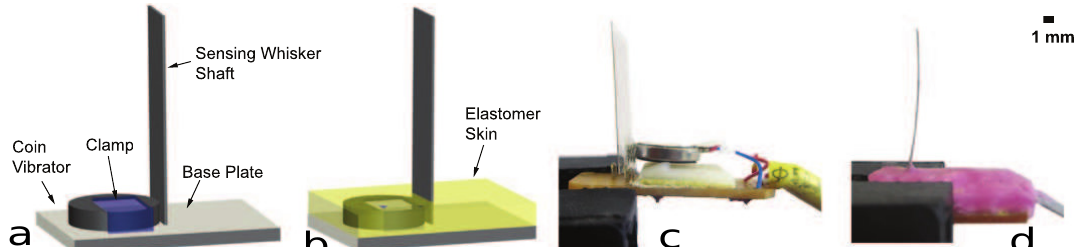
Figure 3. ( a ) the whisker unit without the elastomer skin. The PVDF (Polyvinylidene fluoride) sensing whisker shaft is soldered to the base plate with a very low temperature soldering iron. The coin vibrator is clamped down with the base plate, with one end just touching the whisker shaft; ( b ) the coin vibrator is covered with elastomer skin which improves the coupling between the vibrator and the whisker shaft; ( c ) fabricated sensor model1 without elastomer skin; and ( d ) fabricated sensor model 2 with an elastomer